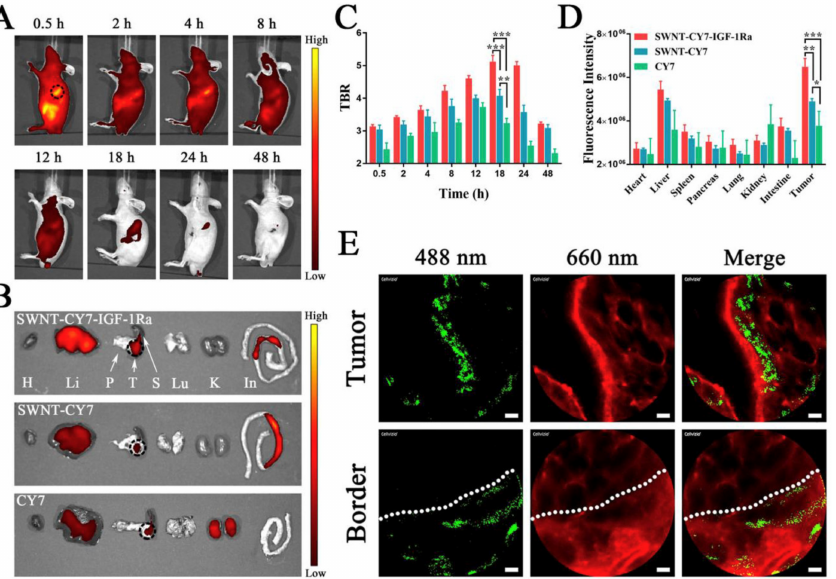
Figure 6. Distribution of nanoprobes in vivo. ( A ) In vivo continuous observations (48 h) of mice administered SWNT-CY7-IGF-1Ra via the tail vein. The black dotted circle represents the location